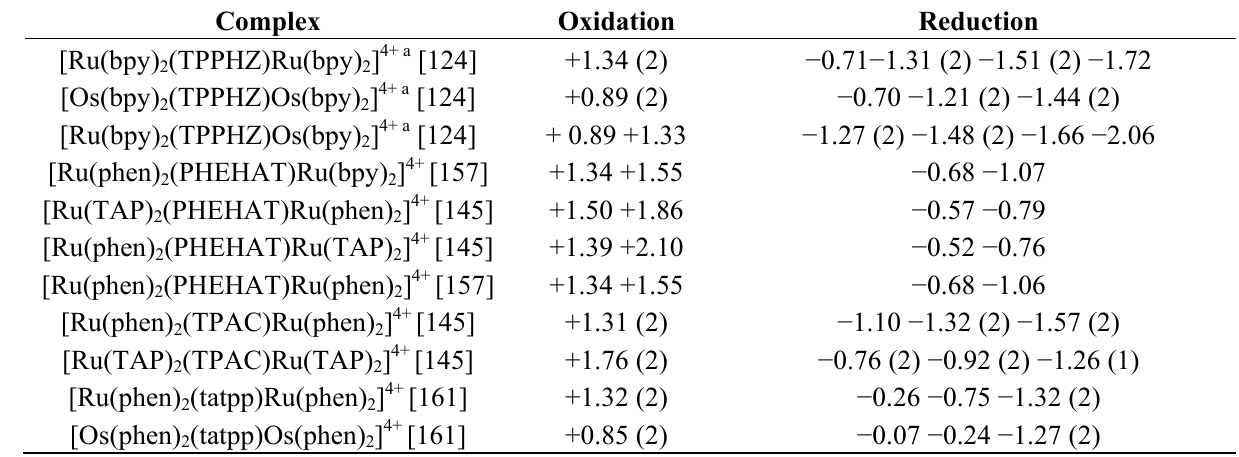
Table 8. Redox potentials V vs. SCE for selected Ru II complexes with extended π -system measured in acetonitrile unless otherwise noted. In parenthesis is the number of exchanged